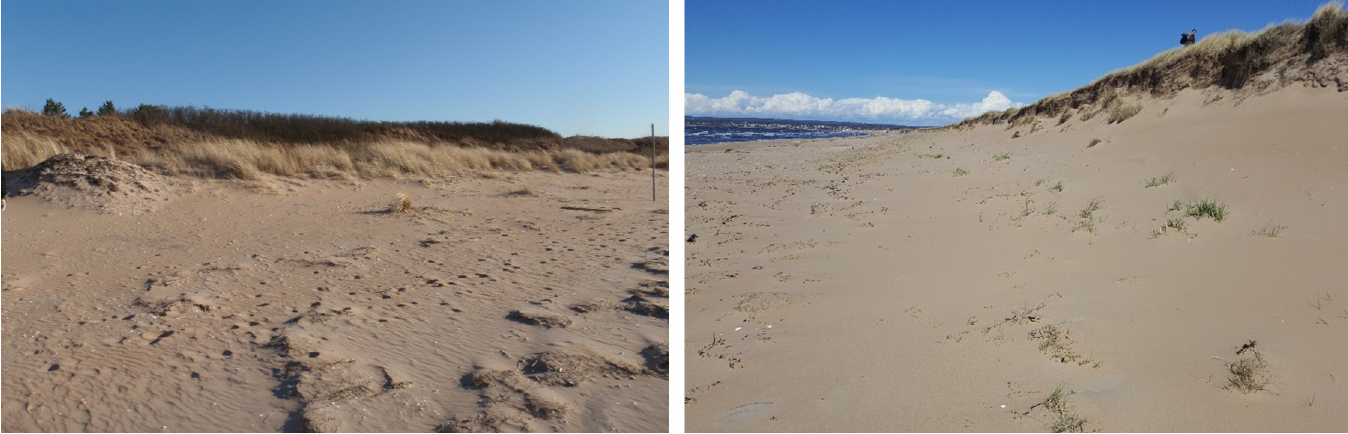
Fig 2. Vegetated embryonal foredune (left) at an accreting beach, and non-vegetated dune ramp (right) at a stable beach in A¨ngelholm, Sweden. The sites are later referred to as profile C and B, respectively.